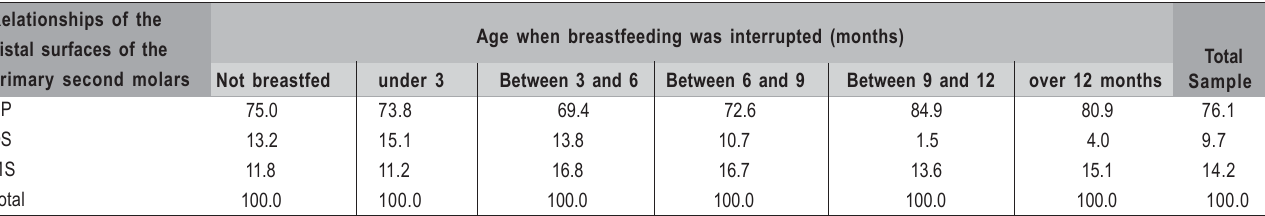
Table 3. Distribution of the relationships of the distal surfaces of the primary second molars according to the age when breastfeeding was